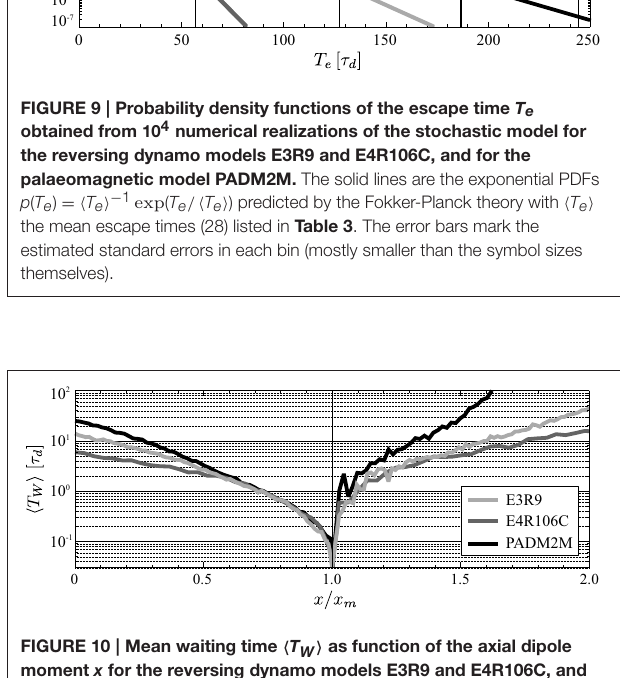
FIGURE 10 | Mean waiting time h T W i as function of the axial dipole moment x for the reversing dynamo models E3R9 and E4R106C, and for the palaeomagnetic model PADM2M. The ADM is normalized with its mode x m (see Table 3 ). The averages are calculated over 10 4 realizations of the stochastic model started with x = x m